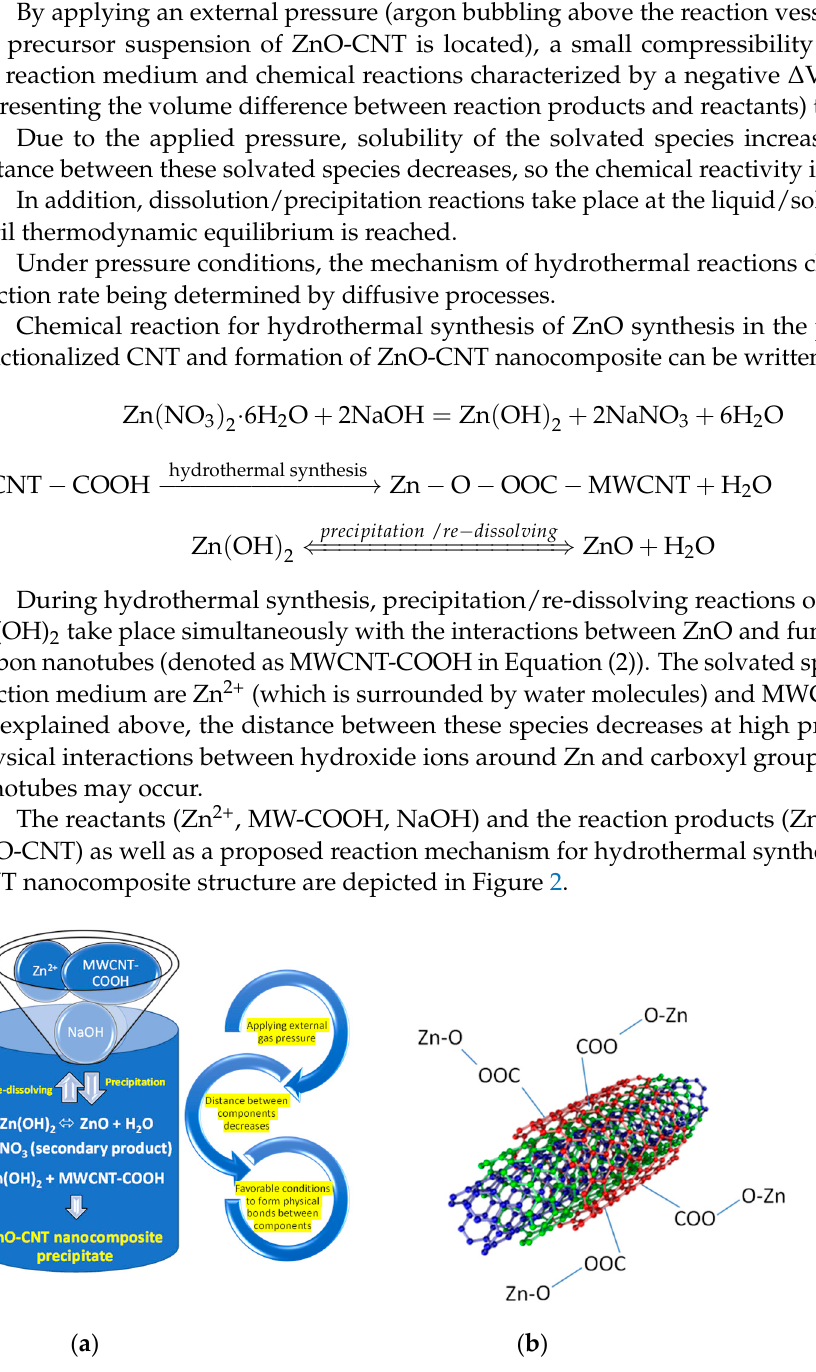
Figure 2. ( a ) The formation of the nanocomposite with physical interactions between the two Figure 2. a) the formation of the nanocomposite with physical interactions between the two com- components (ZnO and MWCNT-COOH); ( b ) possible structure of ZnO-CNT nanocomposite obtained ponents (ZnO and MWCNT-COOH); b) Possible structure of ZnO-CNT nanocomposite obtained by hydrothermal synthesis in high pressure by hydrothermal synthesis in high pressure conditions.